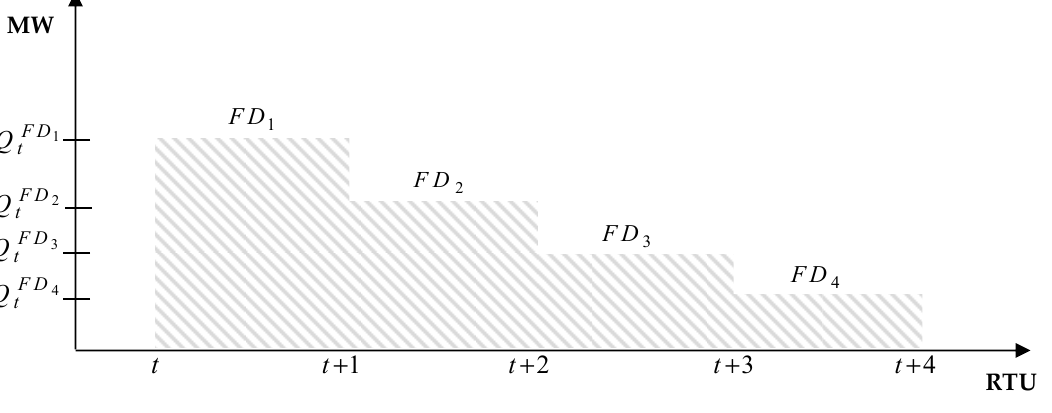
Figure 8. Exclusive in time fully divisible order.